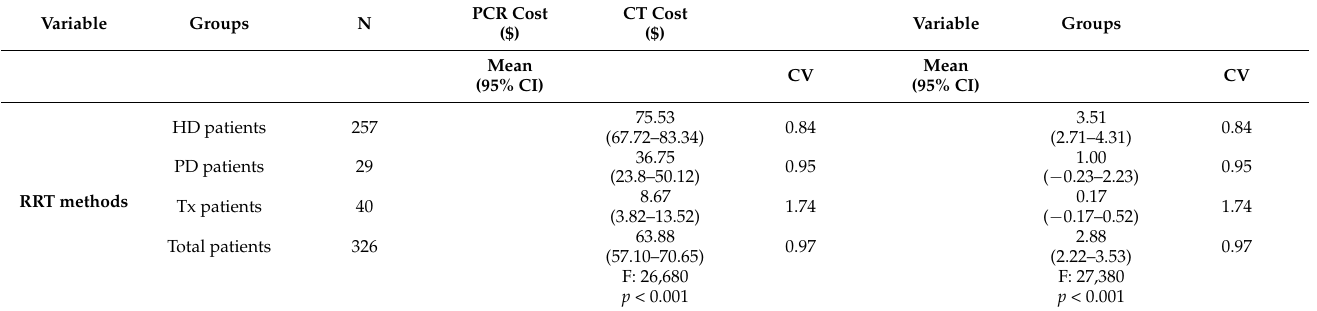
Table 4. The relationship of renal replacement therapy methods with polymerase chain reaction